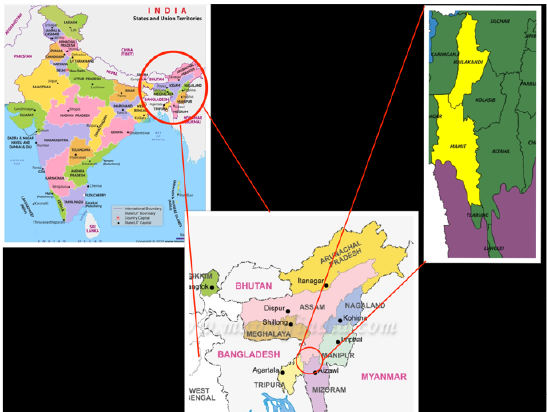
Table 1. Area (km 2 ) under shifting cultivation for Assam and